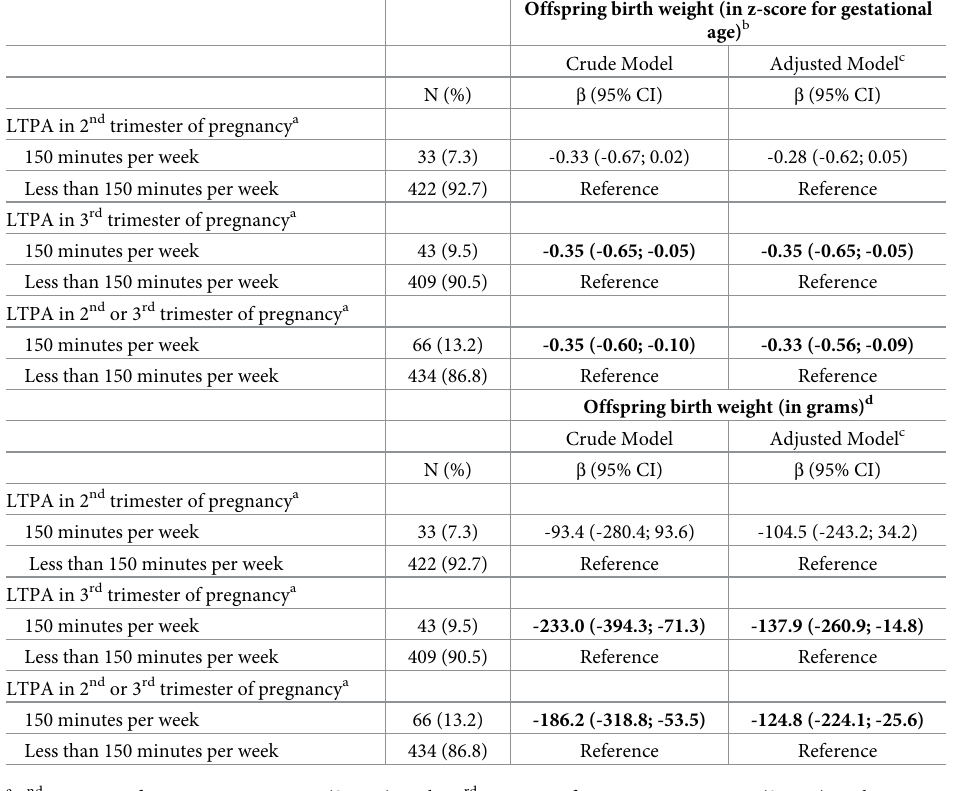
Table 2. Effect of leisure-time physical-activity (LTPA) during pregnancy on offspring birth weight in the MIN- A-Brazil cohort.